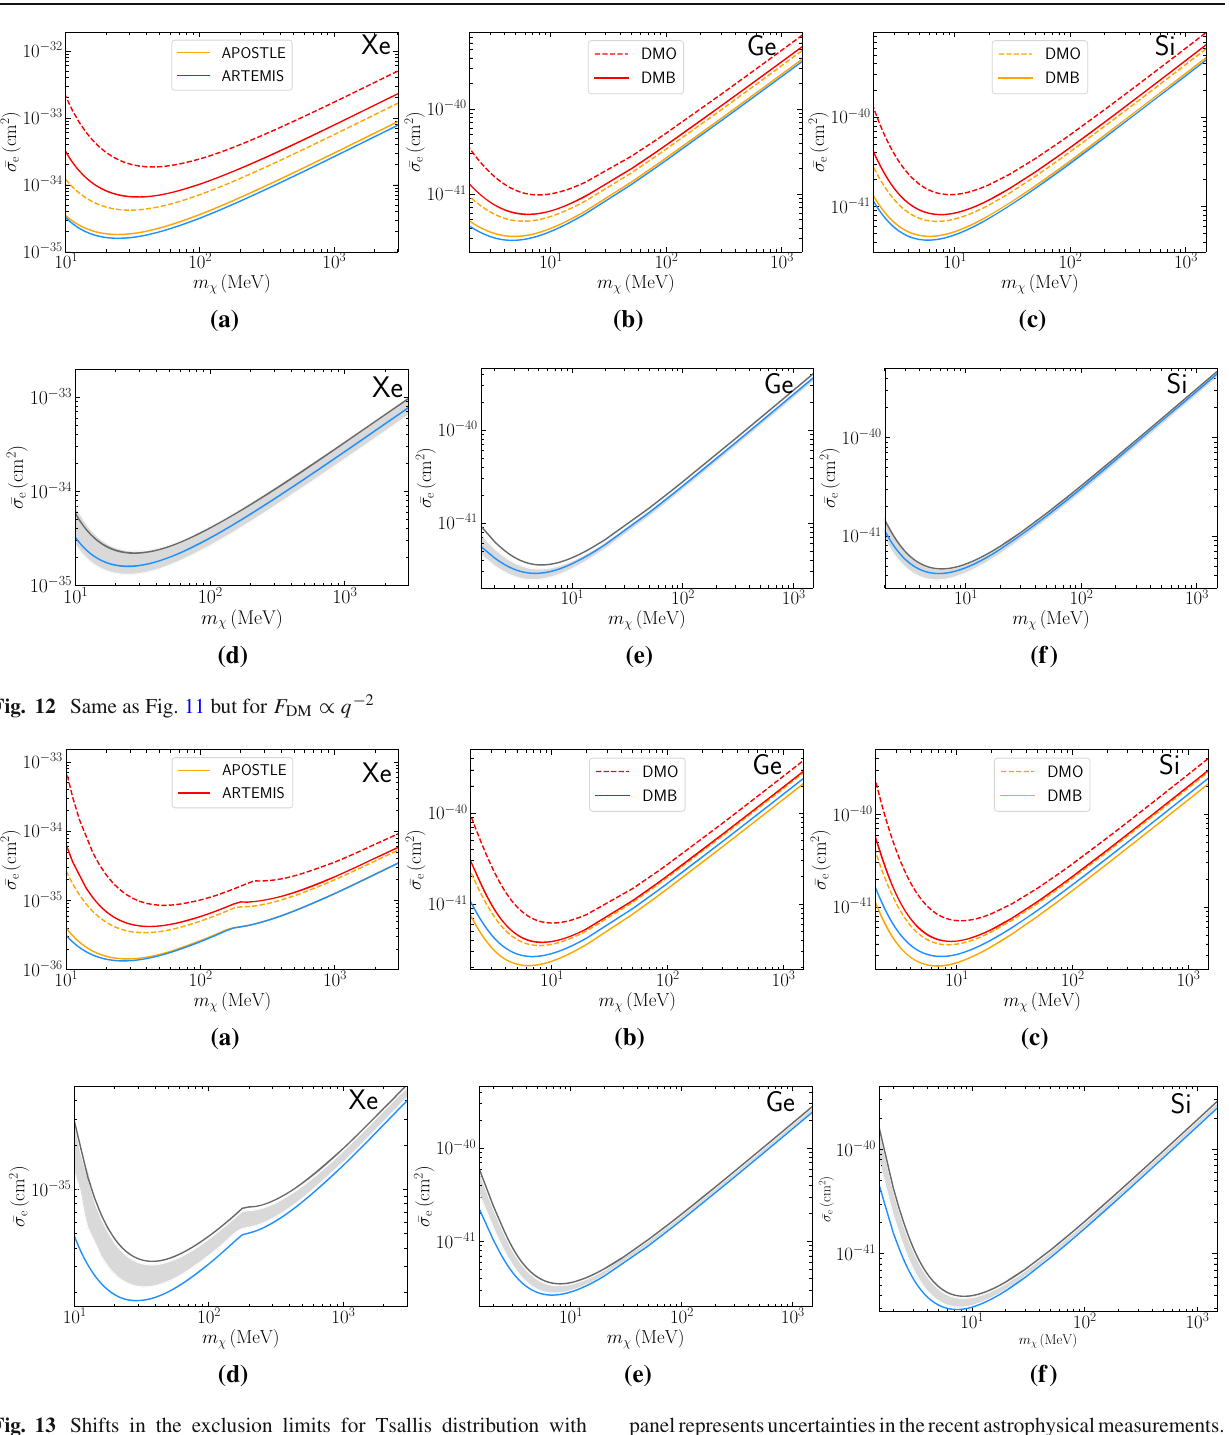
panelrepresentsuncertaintiesintherecentastrophysicalmeasurements. The other relevant details are same as of Figs. 1 and